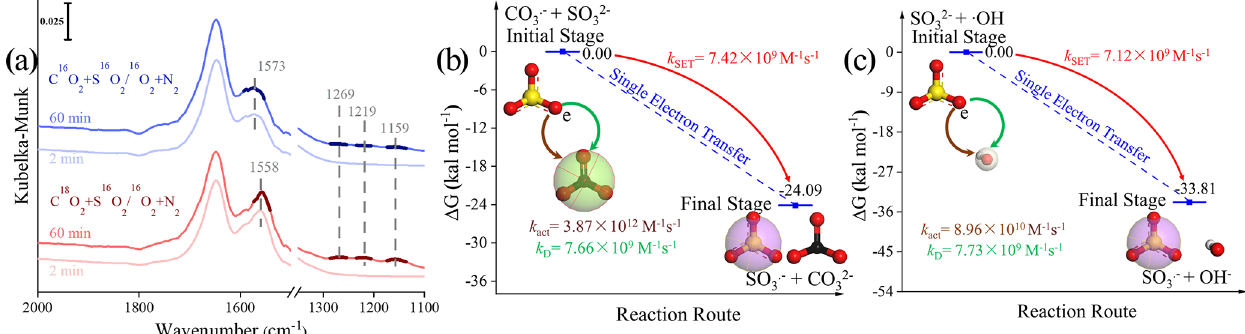
Figure 8. (a) In situ DRIFTS of heterogeneous reaction of SO 2 on the TiO 2 particles for 2 and 60min after being exposed to C 16(18) O 2 / N 2 (cid:113) − for 20min under irradiation. (b) Reaction pathway of the interaction between the carbonate radical (CO ) and sulfite (SO 2 − ) and the 3 3 (cid:113) (c) interaction between the hydroxyl radical ( OH) and sulfite (SO 2 − ) through the SET process at the coupled cluster calculations with 3 all single and double excitations (CCSDs) (T)-F12/cc-PVDZ-F12//M06-2X/6-311 ++ G (3df, 3pd) level (where polarized valence double zeta is PVDZ), and (cid:49)G SET represents the difference in the Gibbs free energy between the reactant and product. The white, black, yellow, 0 and red spheres represent H, C, S, and O atoms, respectively. In order to visualize the variation in the surface products in oxygen isotope experiments (a) , DRIFTS features of these concerned species are highlighted in dark